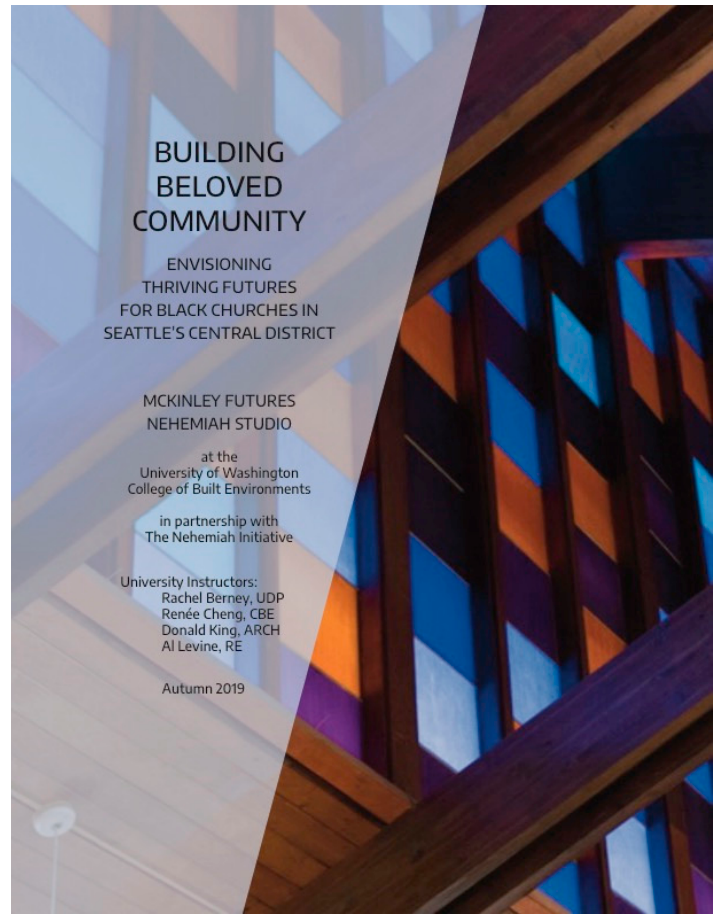
Figure 7. The Autumn 2019 McKinley Futures Nehemiah Studio book.